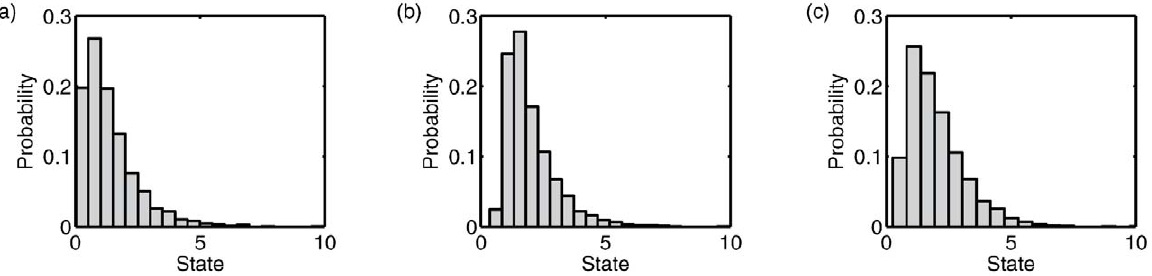
Figure 5. Stationary distributions for elements in networks animated with exponentially distributed noise. Each panel shows an empirical probability distribution as a histogram taken from 3000 data points from element 1 in (a) network 1(b), (b) network 1(d), and (c) network 2(b).